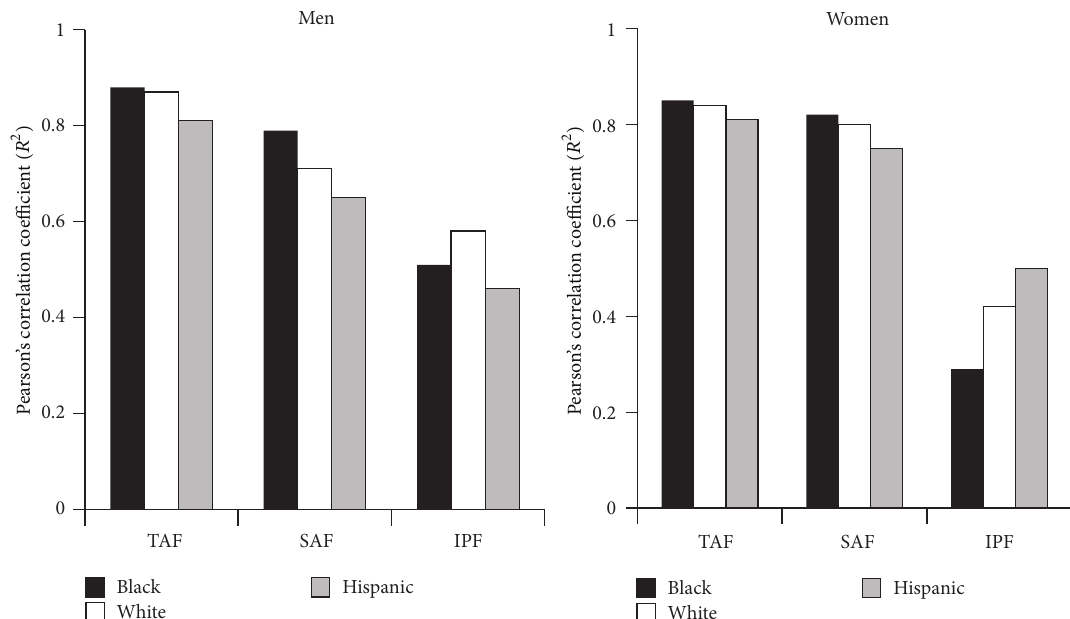
Figure 1: Pearson’s correlation coefficients ( 𝑟 2 ) by ethnicity and gender for linear regression analyses of waist circumference versus total abdominal fat (TAF), subcutaneous abdominal fat (SAF), and intraperitoneal fat (IPF). Highest correlations were found for TAF, intermediate for SAF, and lowest for IPF. All correlations were significant at 𝑃 < 0.001